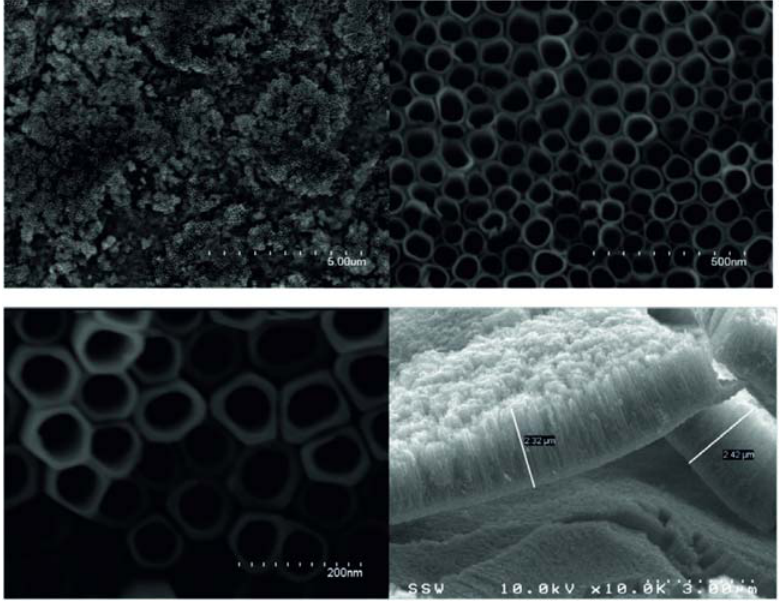
Figure 12. SEM images of Fe–C–N-codoped TiO permission. Copyright (2013) IOP Publishing